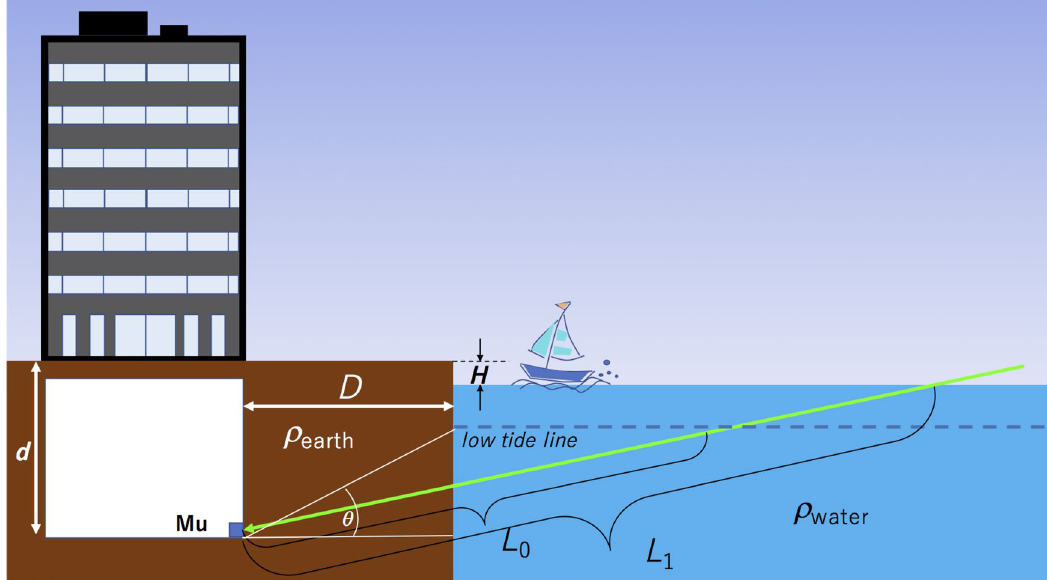
Figure 2. Principle of HKMSDD-MSM tide monitoring. The green arrow and the blue square labeled Mu indicate respectively the muon trajectory and the location of the HKMSDD-MSM. L 0 and L 1 respectively indicate 1. the muon’s path length when the lowest waterline reached during the spring tide and 2. the muon’s path length when sea levels rise due to surges, tsunamis, etc. HKMT drew this image with Microsoft PowerPoint software and holds the